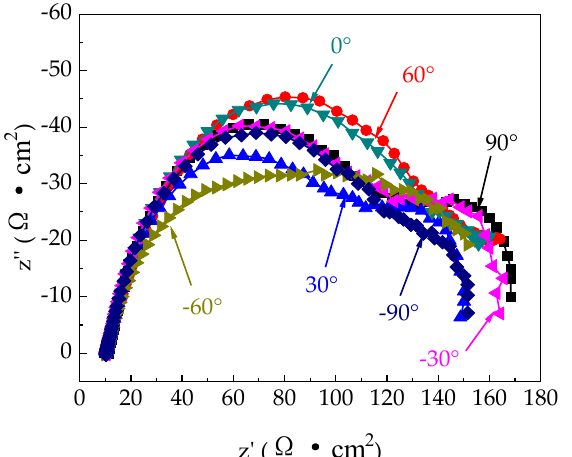
Figure 8. EIS diagram measured on 20 # steel in oil-water-sand flow at different angle positions.